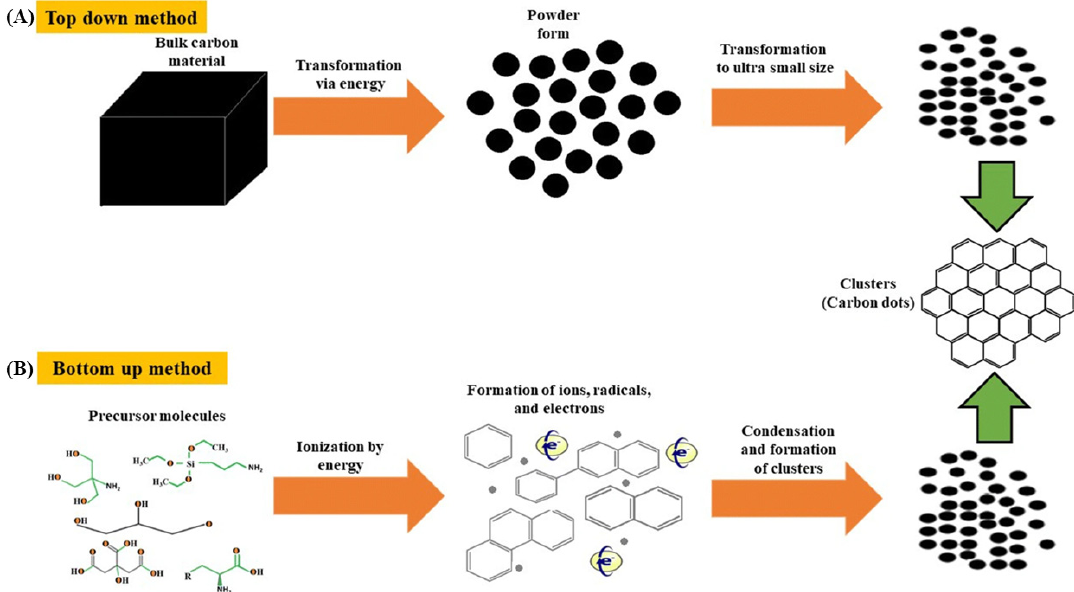
Figure 1. Synthesis of carbon dots by ( A ) top-down and ( B ) bottom-up methods; Reproduced with permission from [15] published by Springer Nature, 2019.